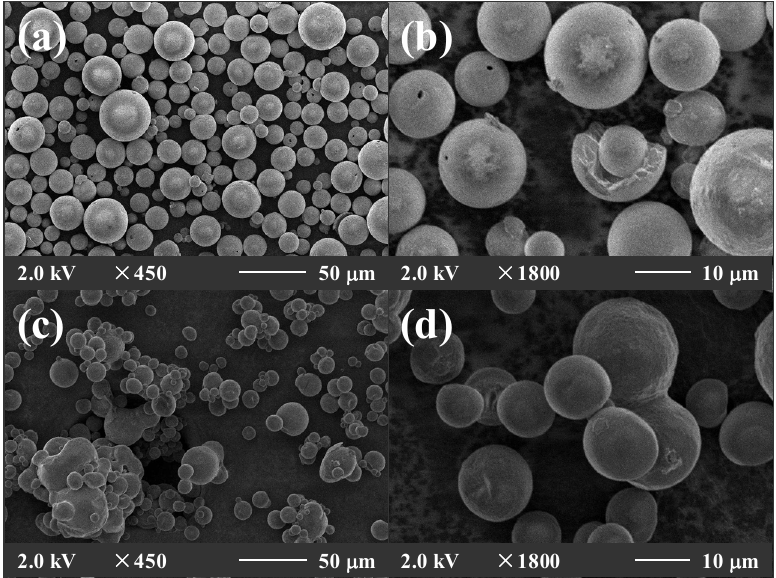
Figure 4. External structures of spray-dried powders. Inlet air temperature, 120 °C; atomizer speed, 20,000 rpm; ( a , b ), mannitol; ( c , d ), the equal-mass mixture of mannitol and MD. ( a ) and ( c ) are 450 times magnification; ( b ) and ( d ) are 1000 times magnification.